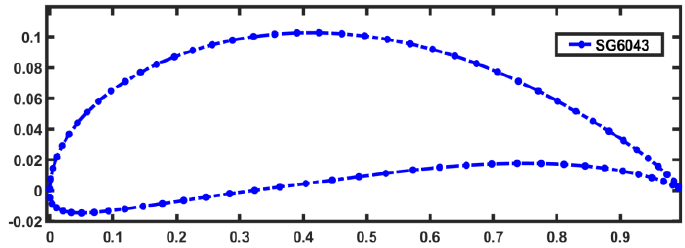
Figure 2. SG6043 Airfoil shape.